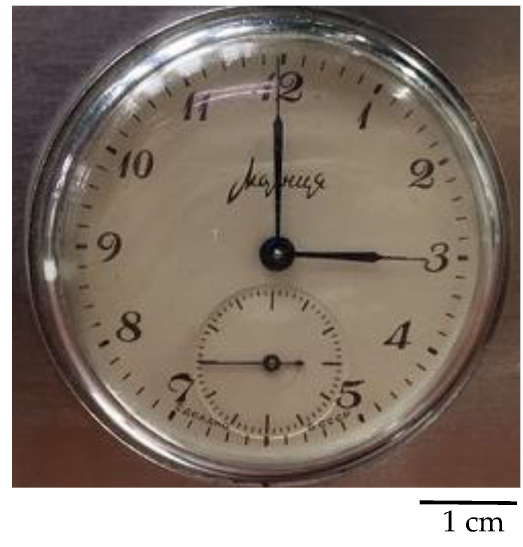
Figure 5. Photo of a pocket watch used as a sample.